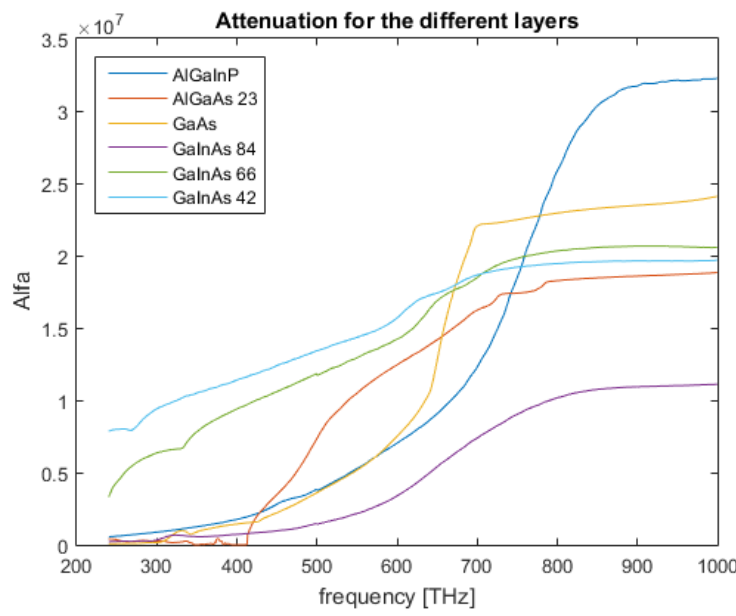
Figure 9. Attenuation of the different